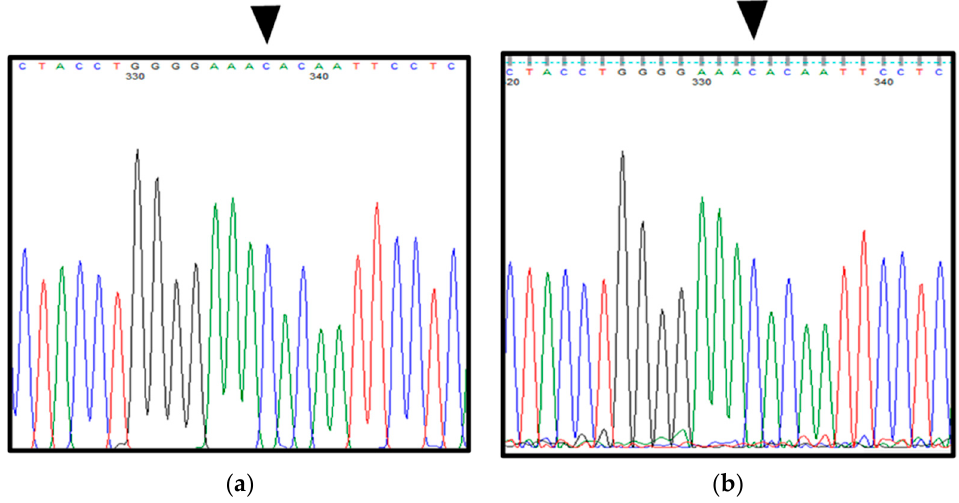
Figure 10. Analysis of the sequence of the entire Gli1 gene in the excised samples and blood in patient 2 based on the Sanger sequencing. ( a ) DNA sequencing in blood in patient 2. ( b ) DNA sequencing in excised samples in patient 2 (synovial tissue). Of note, both the excised material and blood show a point mutation from G to C at exon 12 (rs2228226 G>C) of Gli1 with a change from glutamic acid to glutamine (E1100Q) at amino acid position 1100. In addition, the patient has C/C genotype, reflecting a homozygous variant. Black arrows indicate a point mutation site from G to C in exon 12 of Gli1 .